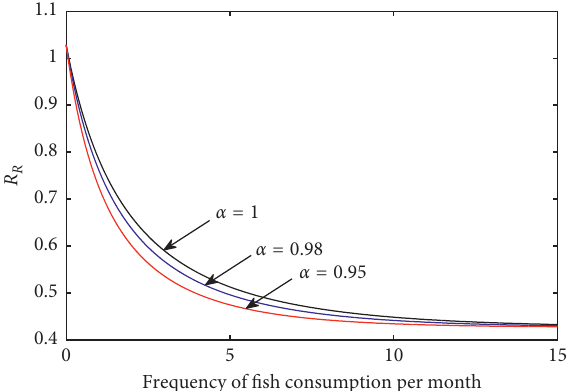
Figure 1: The relative risk R